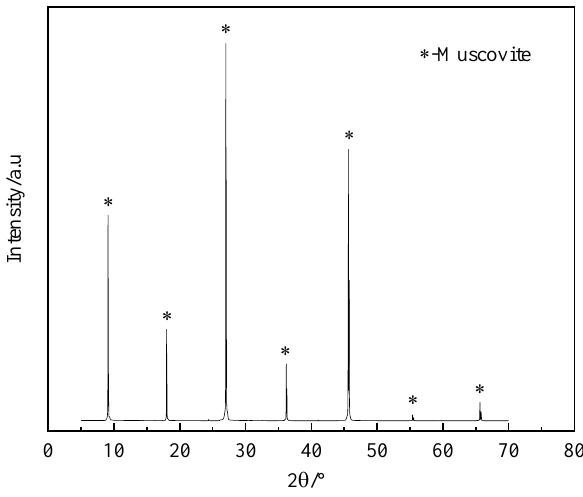
Figure 2. XRD of sample. Table 1. XRF of sample.